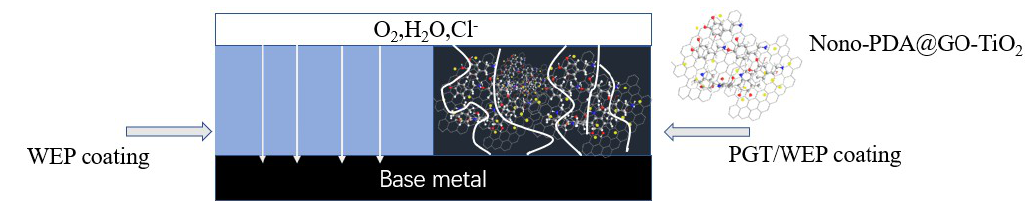
Figure 12. Diagram of the path of corrosive media (O 2 , H 2 O, Cl) through pure waterborne epoxy coating (WEP) and PGT/WEP coating.